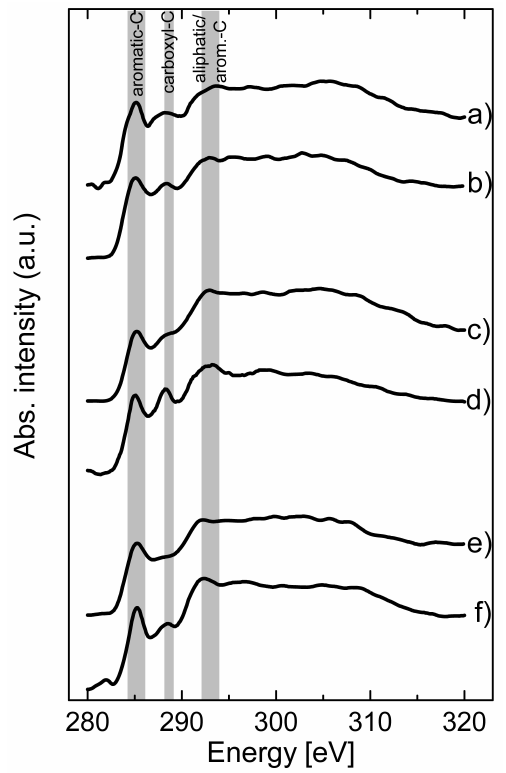
Fig. 5. Averaged C K-edge NEXAFS spectra of (a) fresh soot emit- ted from the Attika wood stove (12), (b) the corresponding aged soot (19), (c) unprocessed soot particles from the EURO 2 trans- porter (7), (d) aged soot particles from the transporter (12), (e) un- processed soot stemming from the EURO 3 passenger car (5), (f) aged soot from the passenger car (9), values in brackets define the number of spectra used for averaging.